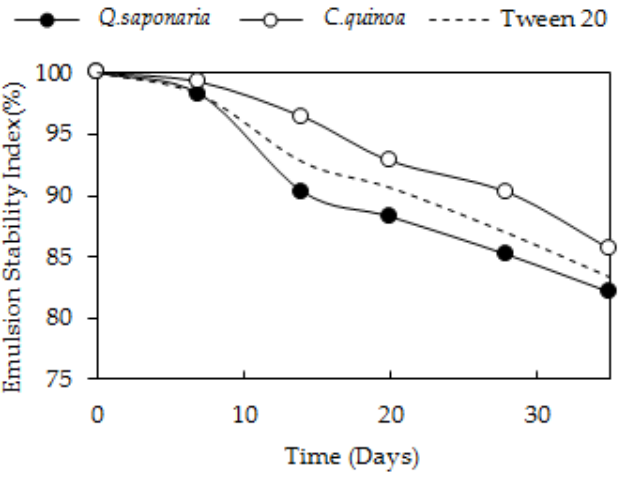
Figure 4. Emulsion stability index (ESI) after 35 days of storage at 25°C for emulsions prepared with ( ● ) Quillaja saponaria , ( ○ ) Chenopodium quinoa or (--) Tween 20 as emulsifier.